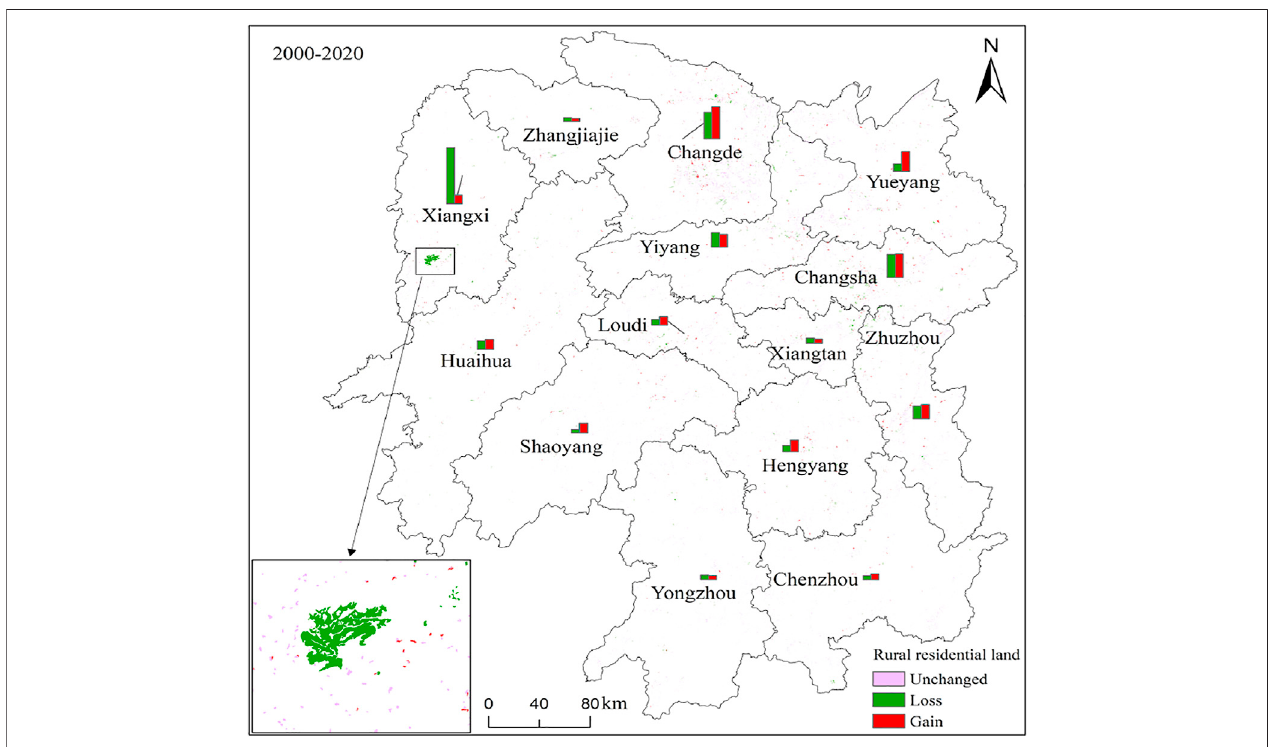
FIGURE 2 | Distribution of RRL change in 2000 –